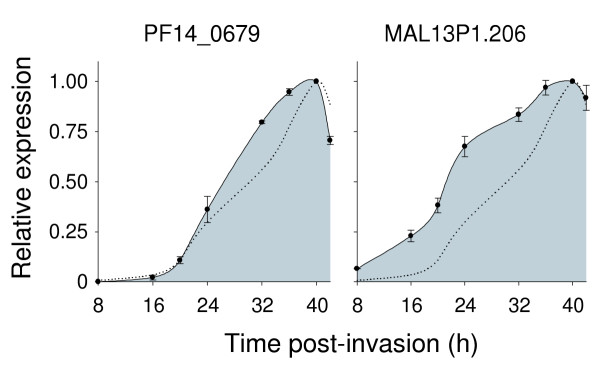
Stage-dependent gene expression of the putative inorganic anion exchanger (PF14_0679) of the sulphate permease family and the Pi :Na+ symporter (MAL13P1.206) of the inorganic phosphate transporter family, throughout the intraerythrocytic cycle of P. falciparum. The analysis was carried out as described in the legend to Figure 4.